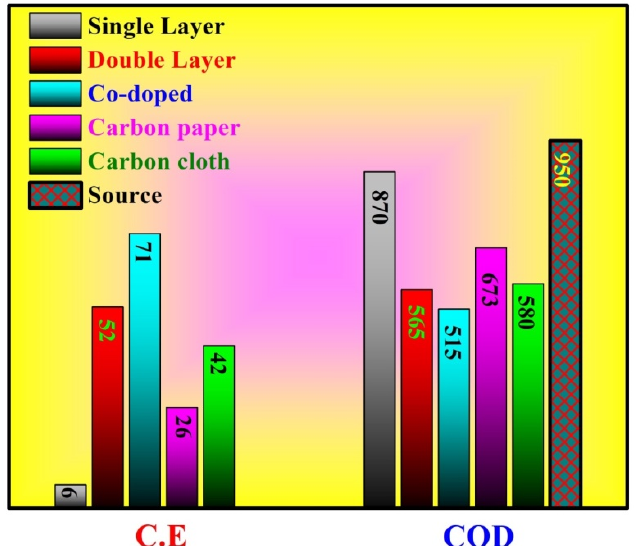
Figure 10. Columbic efficiency (CE) and COD of the final solution after 24 h batching of MFCs using different anodes.